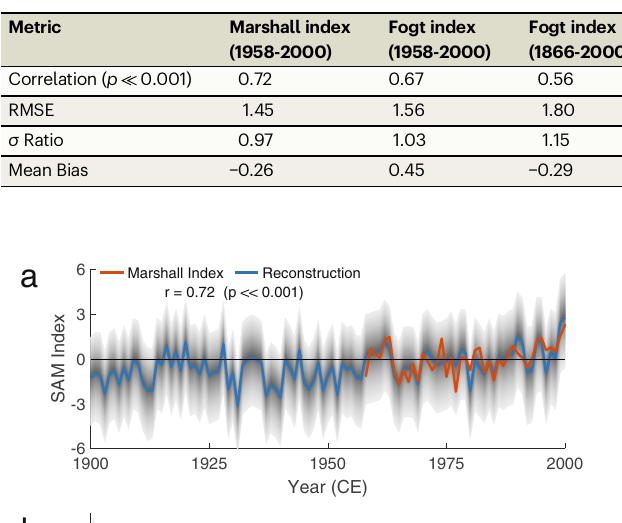
Table 1 | Reconstruction Skill metrics for the Southern Annu- lar Mode calculated against instrumental indices over the given time periods